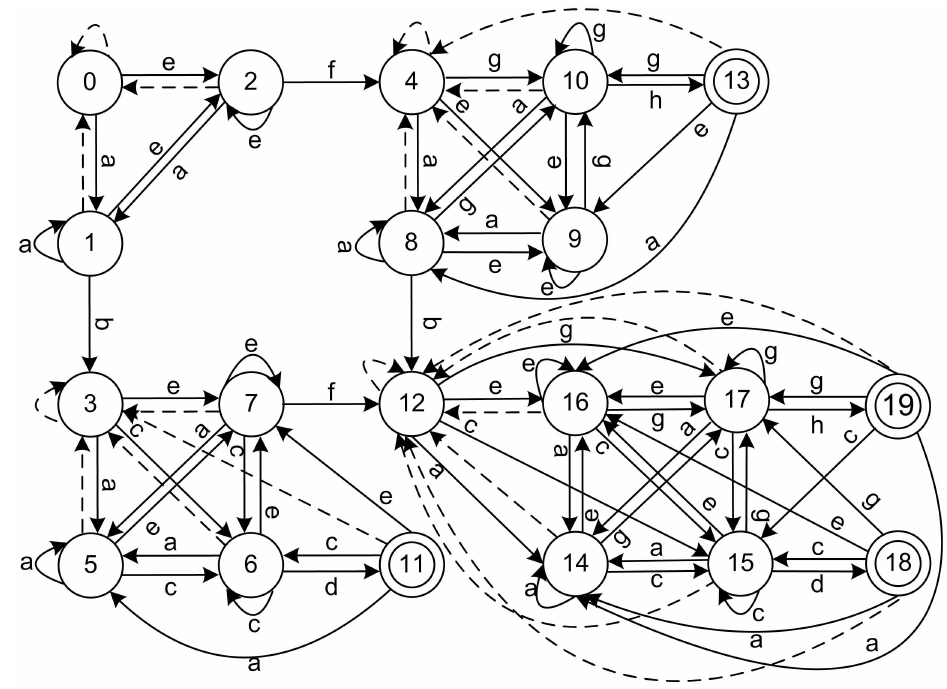
Fig 1. Original DFA state transition digraph for regular expressions (ab. * cd, ef. * gh). The numerical circle represents states in DFA, and the state with doublecircles represents it is an acceptedstate. The direct edges with a symbol represents transitions in DFA, and the dashed direct edges represents transitions transfer to a common state with symbols that have not been shown.